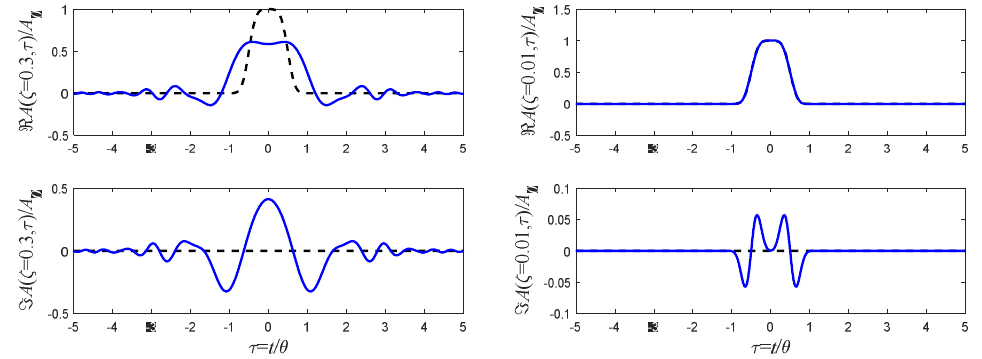
Figure 17. Same as Figure 12, but for Equation (64) with the transition width ∆ = 0.2 θ